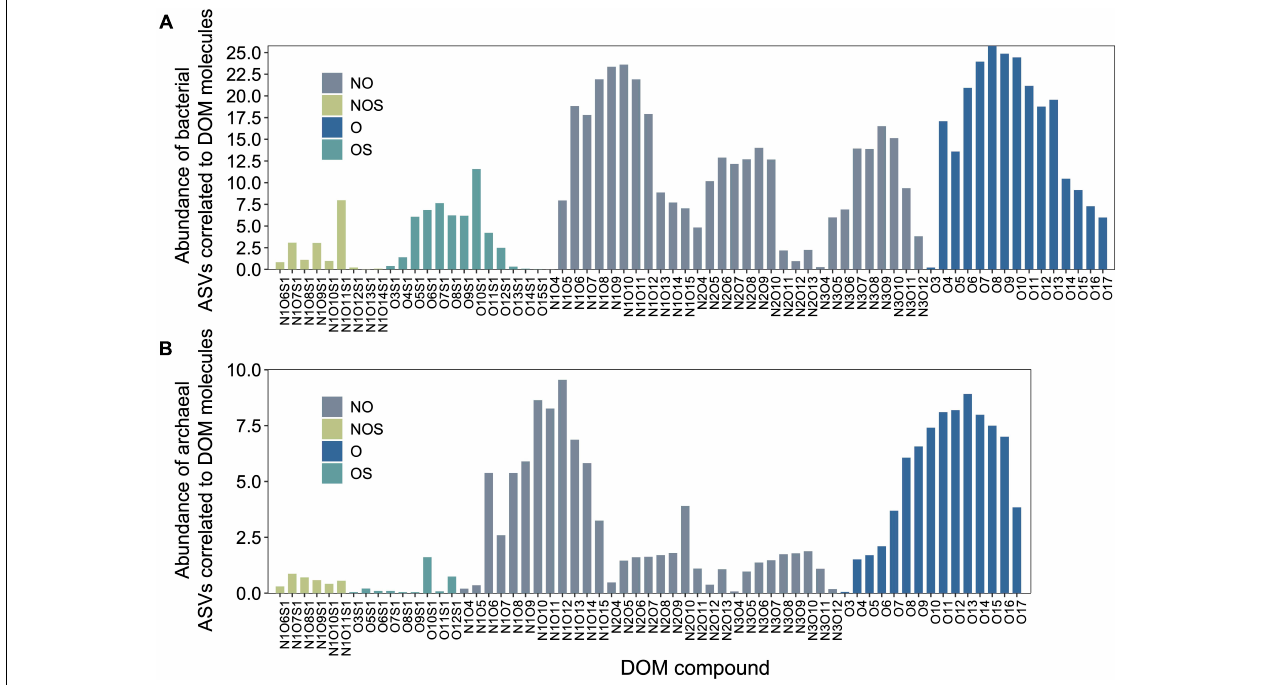
FIGURE 4 | DOM compounds of molecules significantly correlated (Pearson’s correlation with r ≥ 0.65, P < 0.01) with bacterial (A) and archaeal communities (B) . ASV, amplicon sequence variant.